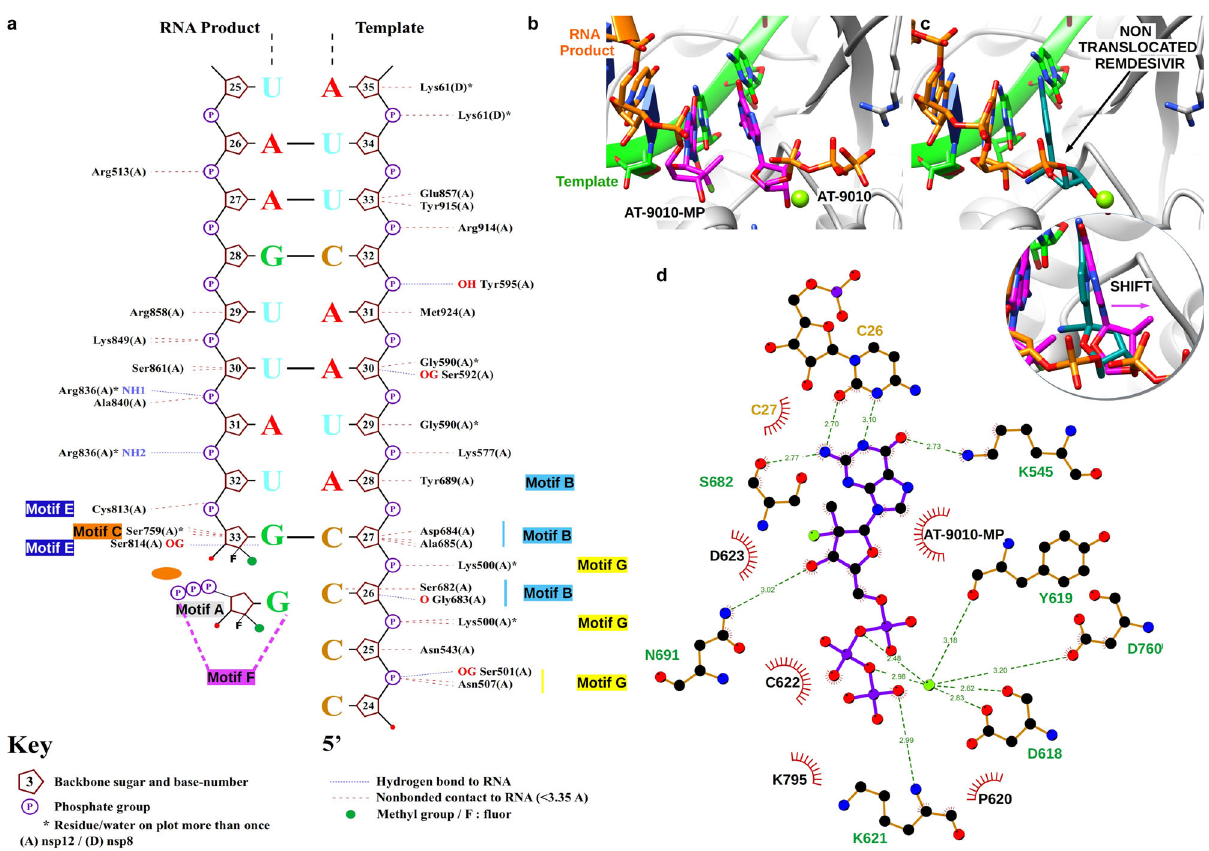
Fig. 2 Structural basis for inhibition of the SARS-CoV-2 polymerase complex by AT-9010. a Nucplot molecular analysis with RNA, AT-9010 and nsp12. b Close up of RdRp catalytic site following AT-9010 incorporation. c Close up of RdRp catalytic site following remdesivir incorporation (PDB 7BV2). Both structures in panel b and c are in the same orientation, superimposed by least squares fi t method (shown in circle). One AT-9010 5 ’ -monophosphate (AT- 9010-MP) is incorporated into the primer RNA strand, and terminates RNA elongation. The second AT-9010 molecule, coordinated by one ion, occupies the NTP-binding site in comparison, remdesivir is terminally incorporated, and untranslocated. Superimposition shows the incoming ( − 1) AT-9010 ribose group is shifted with the phosphates in a post-incorporation position. Ribbons are depicted as follows: nsp12, blue; nsp7, pink; nsp8 1 and nsp8 2 , yellow and cyan, respectively; RNA, green sticks; AT-9010, magenta sticks. d Ligplot 2D analysis of the contacts of AT-9010 molecule with nsp12, and incorporated